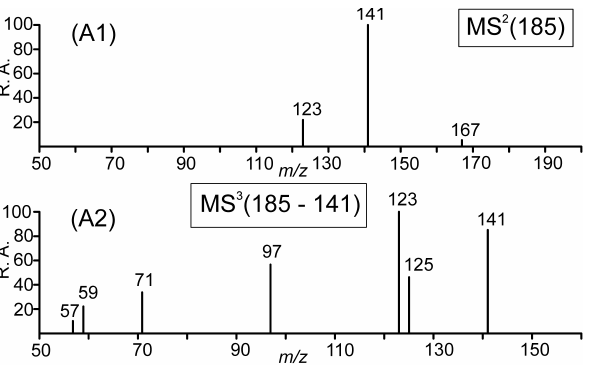
Fig. 4. ( − )ESI-MS data for the SOA product formed upon ozonol- ysis of β -pinene with RT 18.8min (Fig. 1B), tentatively assigned to homoterpenylic